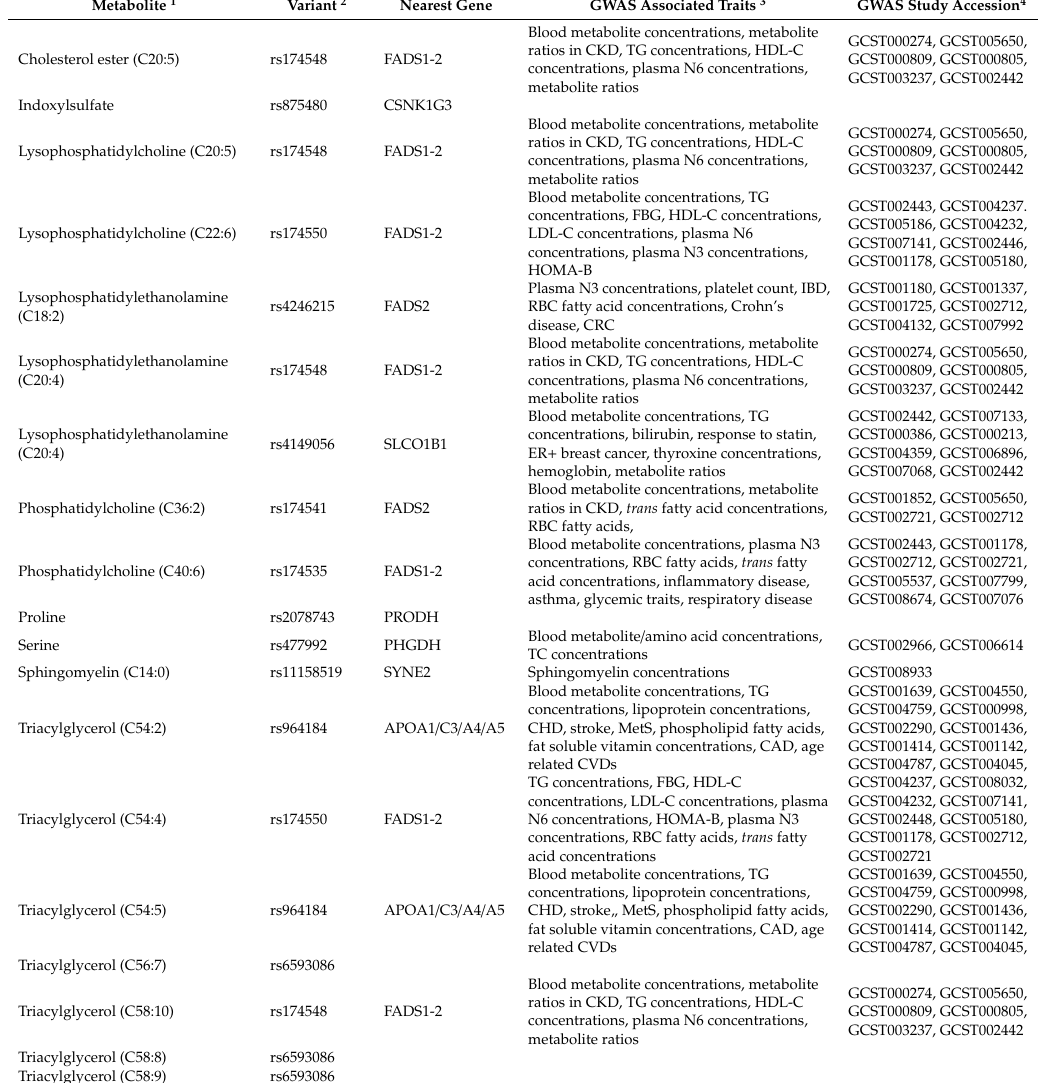
Table 6. Overlap among dietary metabolite quantitative trait loci and prior genome-wide association study risk loci.